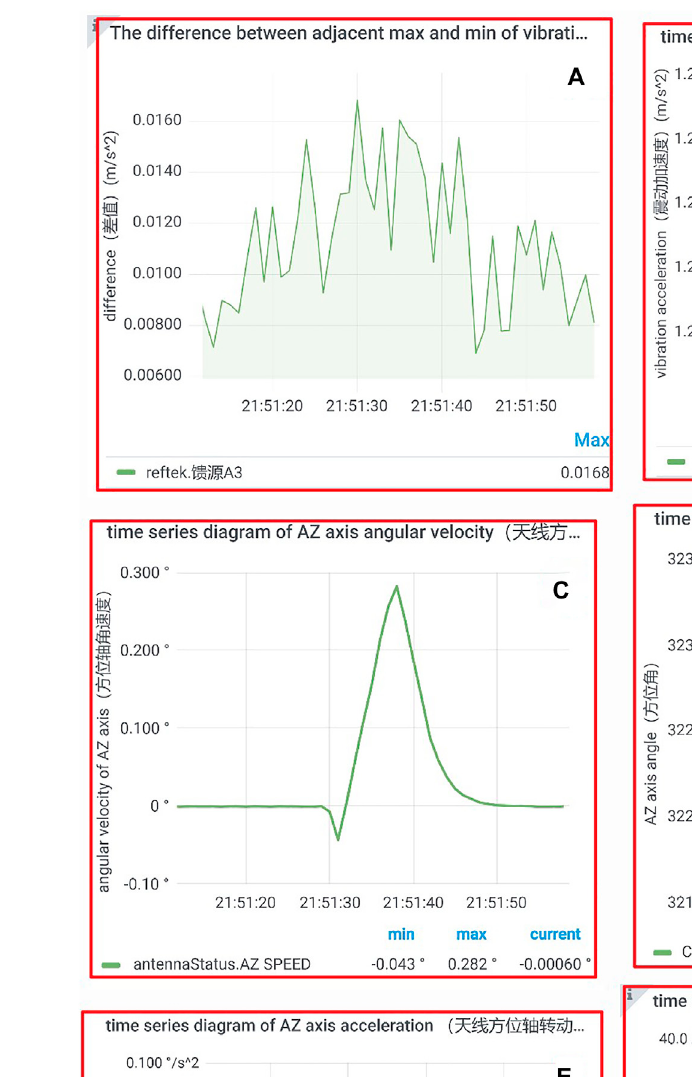
Frontiers in Astronomy and Space Sciences |